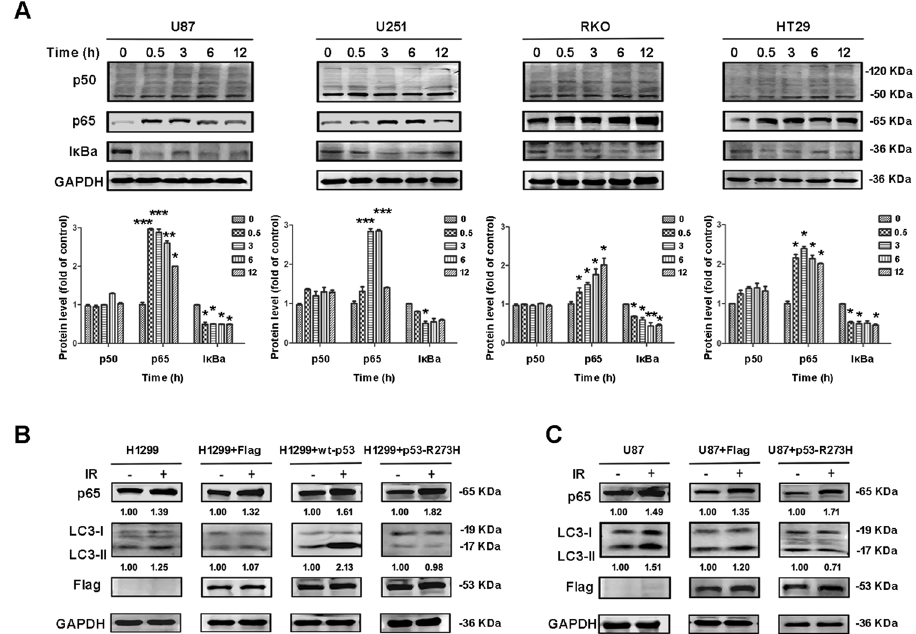
Fig. 2 The level of LC3 may be associated with NF- κ B activation after IR. A Western blotting analysis of the levels of p50, p65, and I κ Ba proteins at different time points after IR (12 Gy) in U87, U251, RKO, and HT29 cells. B After transfecting with Flag, wild-type p53, and mutant